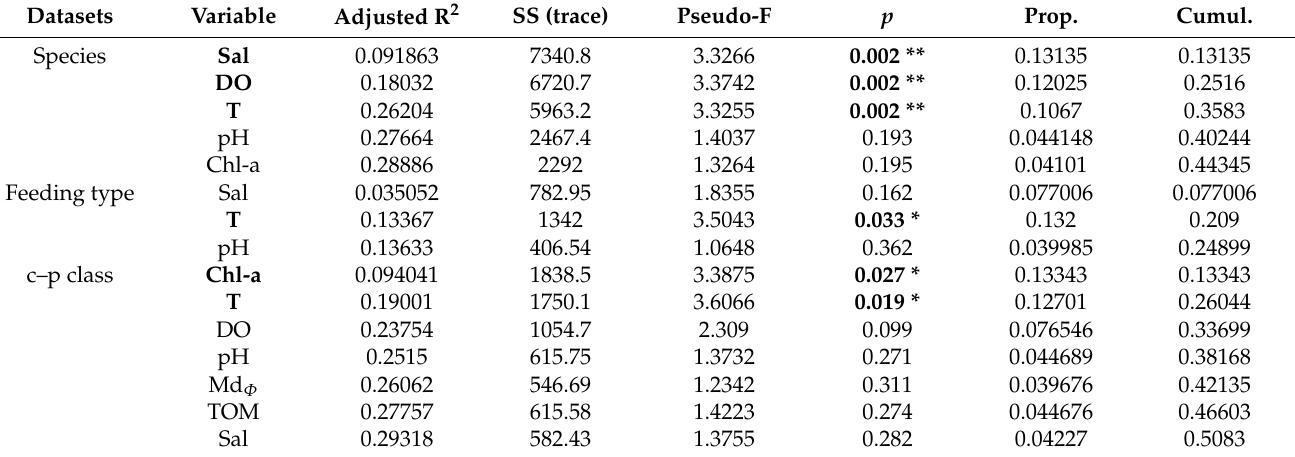
Table 6. Results of the DistLM sequential test for nematodes datasets of GB. SS, sum of square; F, F statistic; Prop, the proportion of the variability explained; T, sea water temperature; Sal, sea water salinity; DO, sea water dissolved oxygen; Chl-a, Chlorophyll-a; TOM, total organic matter; Md Φ , median particle diameter. **, p < 0.01; *, p < 0.05. Statistically significant correlations are indicated in